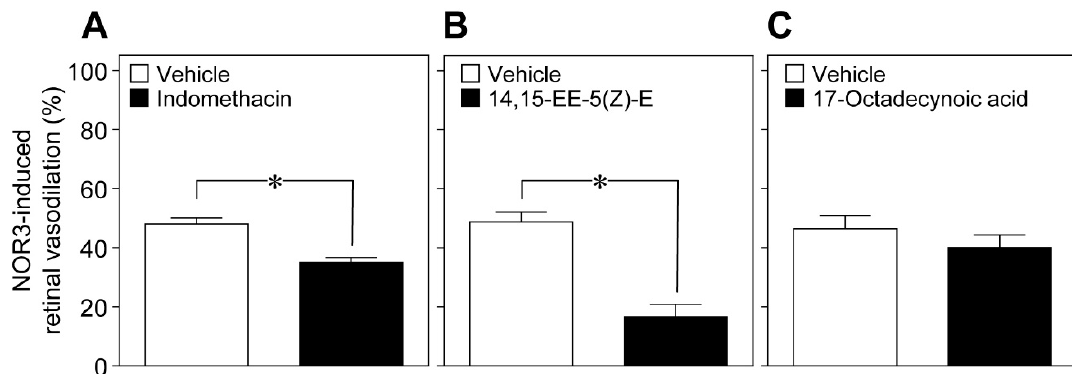
Figure 7. Involvement of prostaglandins and epoxyeicosatrienoic acids in the retinal vasodilation induced by intravitreal injection of NOR3. NOR3 (5 nmol)-induced changes in the retinal arteriolar diameter in the presence of ( A ) indomethacin (10 nmol), ( B ) 14,15-EE-5(Z)-E (0.7 nmol), ( C ) and 17-octadecynoic acid (1.4 nmol). Each column with a vertical bar represents the mean ± SE from four animals. * p < 0.05.